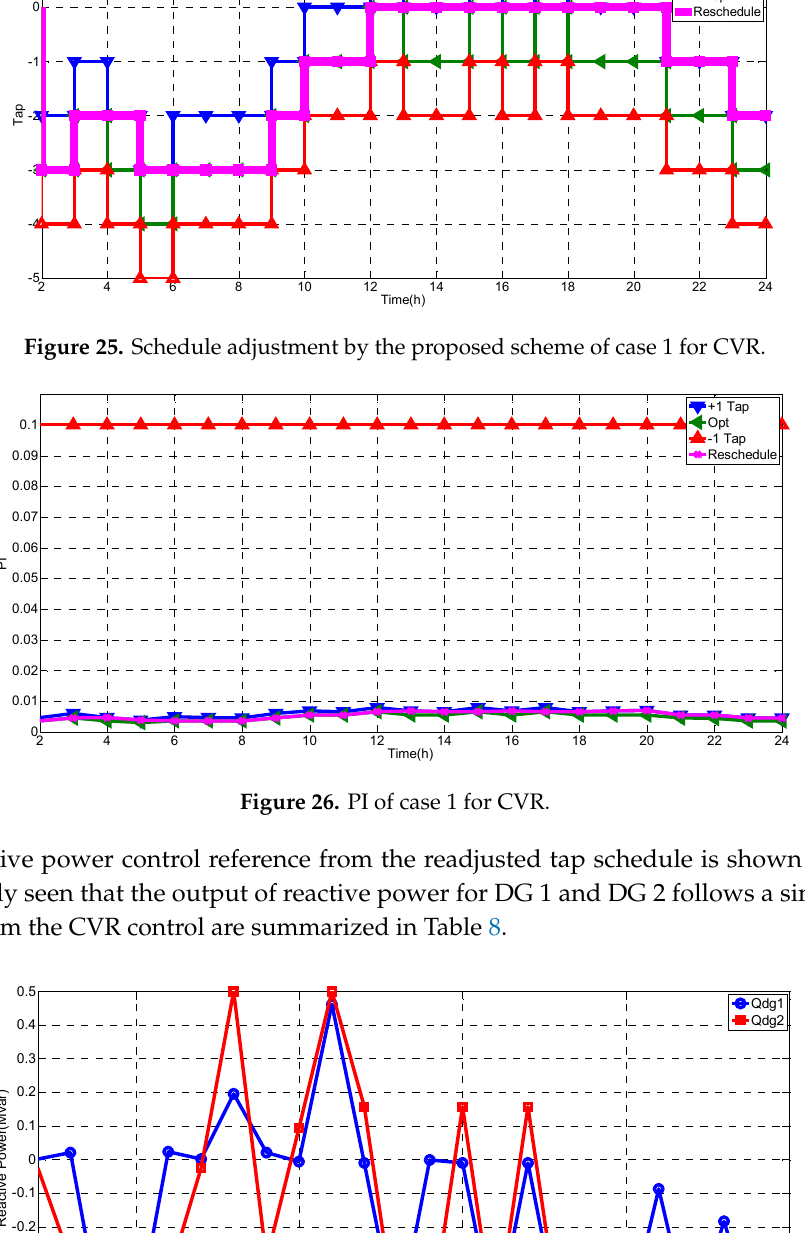
19 of 23 Figure 24. Reactive power reference of case 1 for nominal voltage. Table 7. Comparison of the number of tap operations, PI total, sum of reactive power with/without